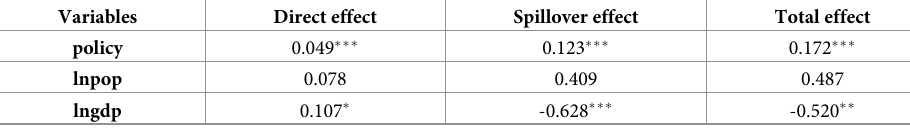
Table 6. Empirical results of decomposition of spatial effect based on the asymmetric weight matrix.